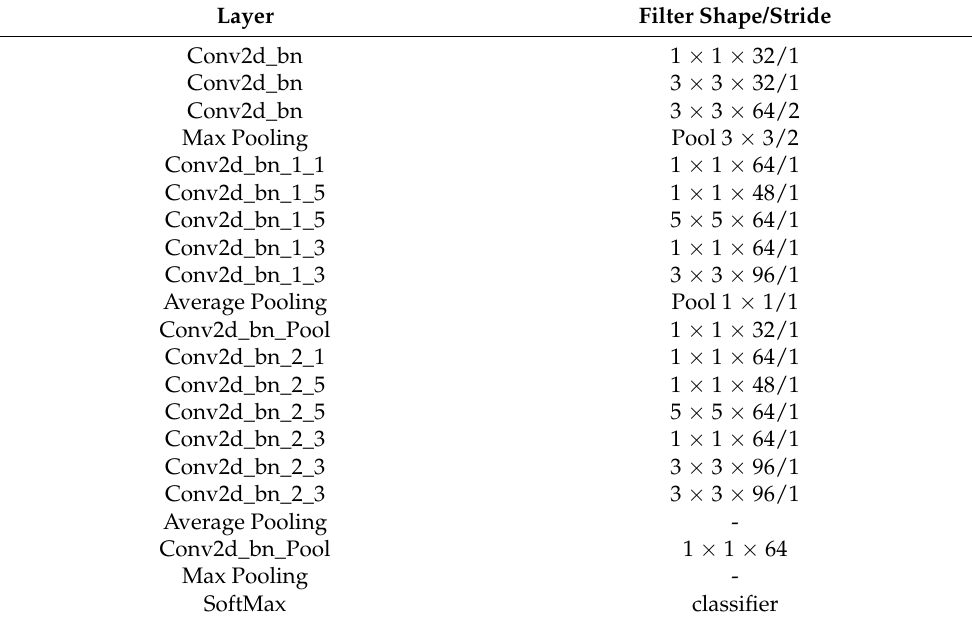
Table 3. Structure of Tiny Inception V3: the building blocks are shown, with the size of the filter bank and the numbers of stride stacked.